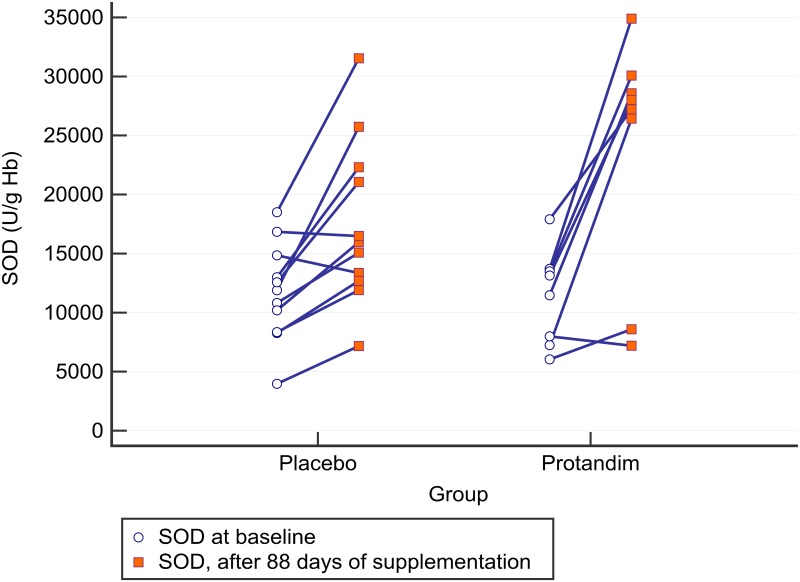
Individual changes in superoxide dismutase (SOD) in runners ≥ 35 years of age (range = 35 to 46 years of age).Those taking Protandim® for 88 days (n = 8) showed a 2-fold higher increase in SOD compared to the 11 runners taking the placebo (Group x Time interaction effect, p = 0.038). The effect size for the between group change between Protandim® and placebo was +1.00 (Bias corrected, Hedges) (95% CI of the effect size = 0.03 to 1.96) in favor of Protandim®.